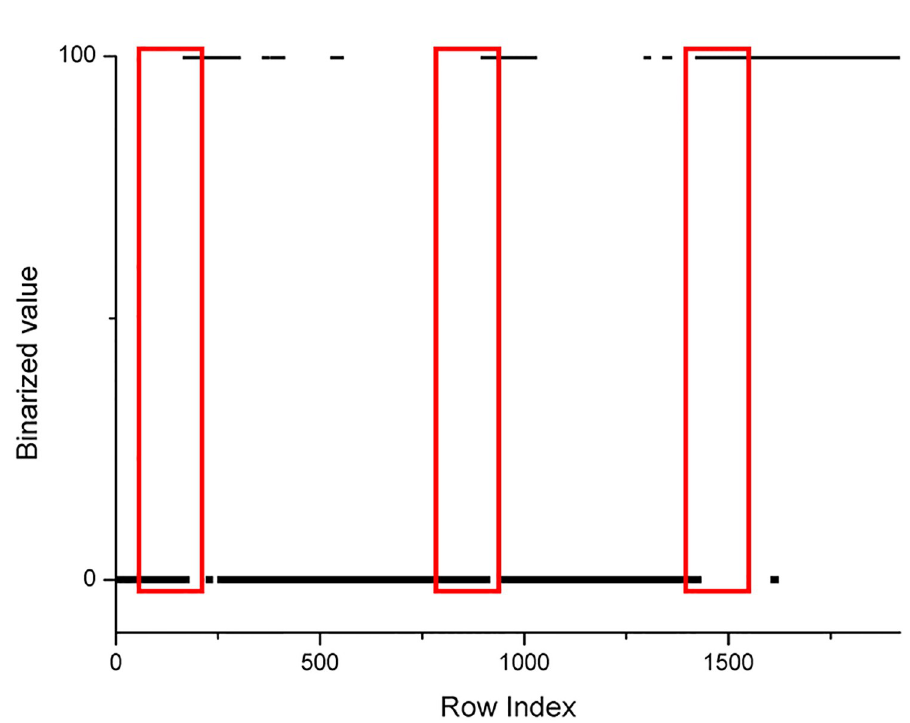
Fig 11. Scatter plot of the number of black pixels of Fig 8B after binarization.